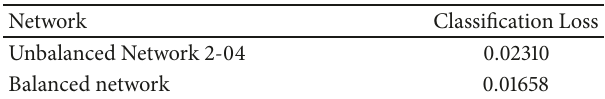
Table 7: CL for Network 2-04 compared to the new balanced